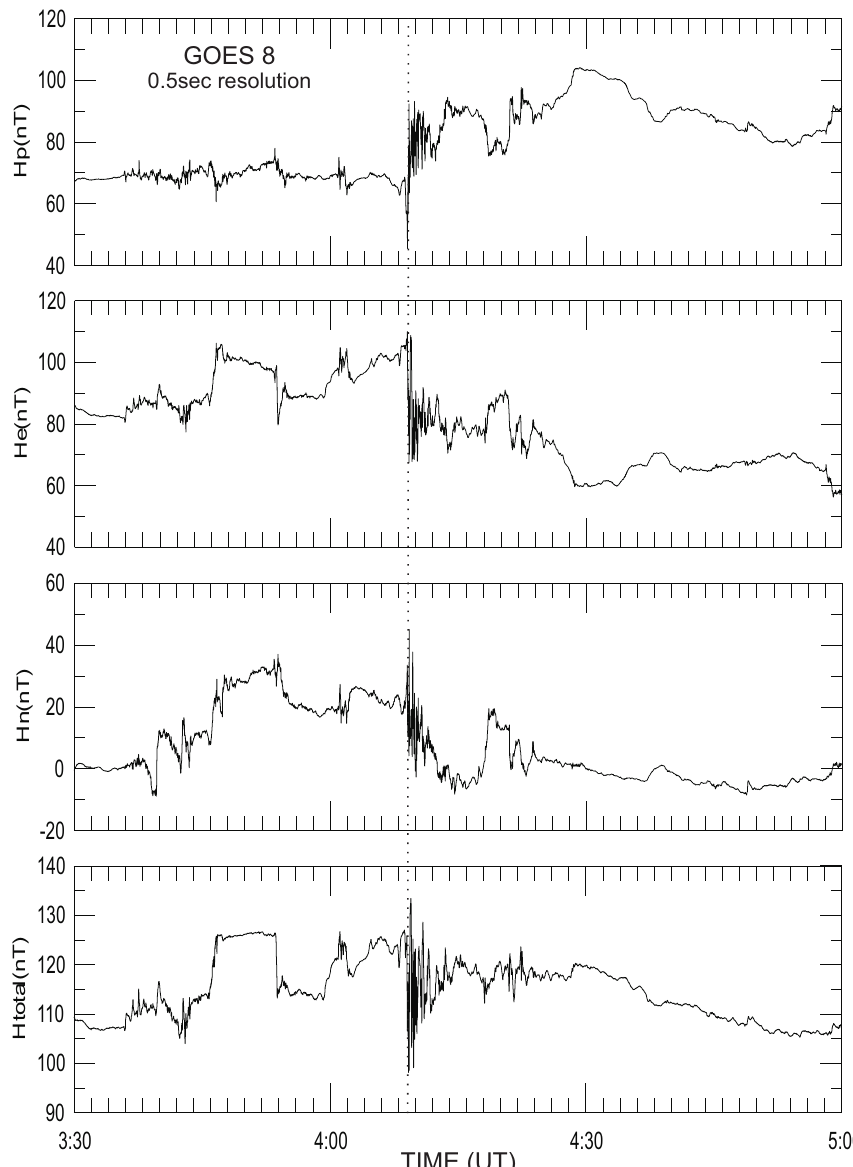
Fig. 4. GOES 8 magnetic field measurements showing a dipolarization onset time at ∼ 04:09